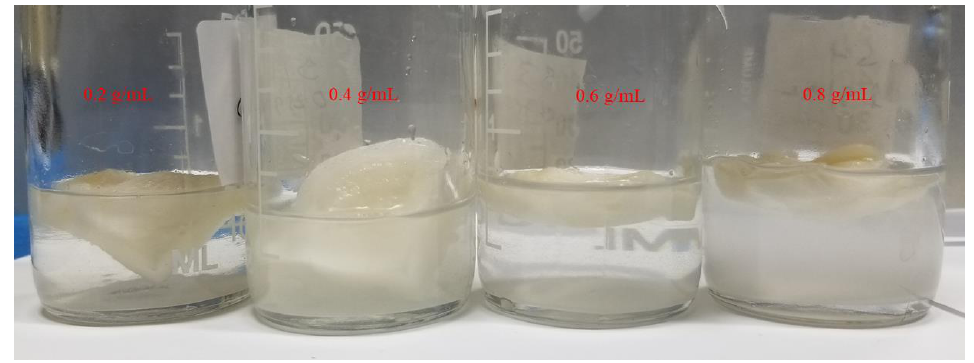
Figure 3. Digital photos of PAN/AM hydrogels immersed in different concentrations of CaCl 2 solutions.